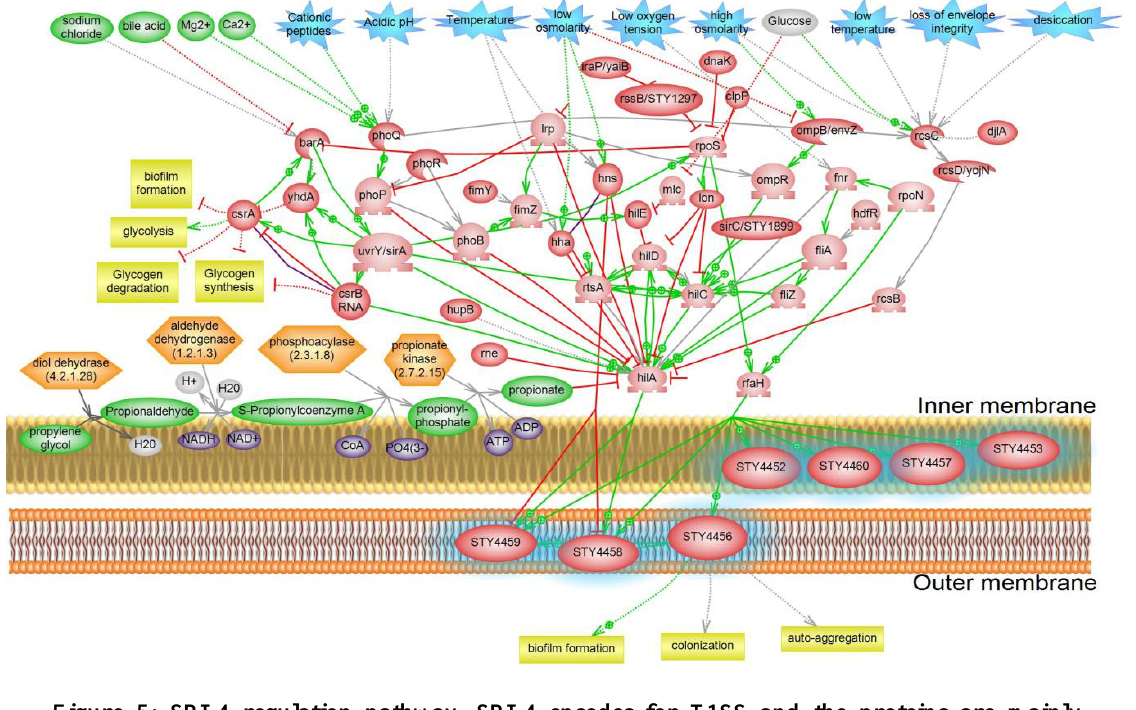
Figure 5: SPI-4 regulation pathway. SPI-4 encodes for T1SS and the proteins are mainly regulated by HilA and RfaH. Proteins encoded by SPI-4 are highlighted in blue. A detailed view of SPI-4 pathway including supporting literature is available at